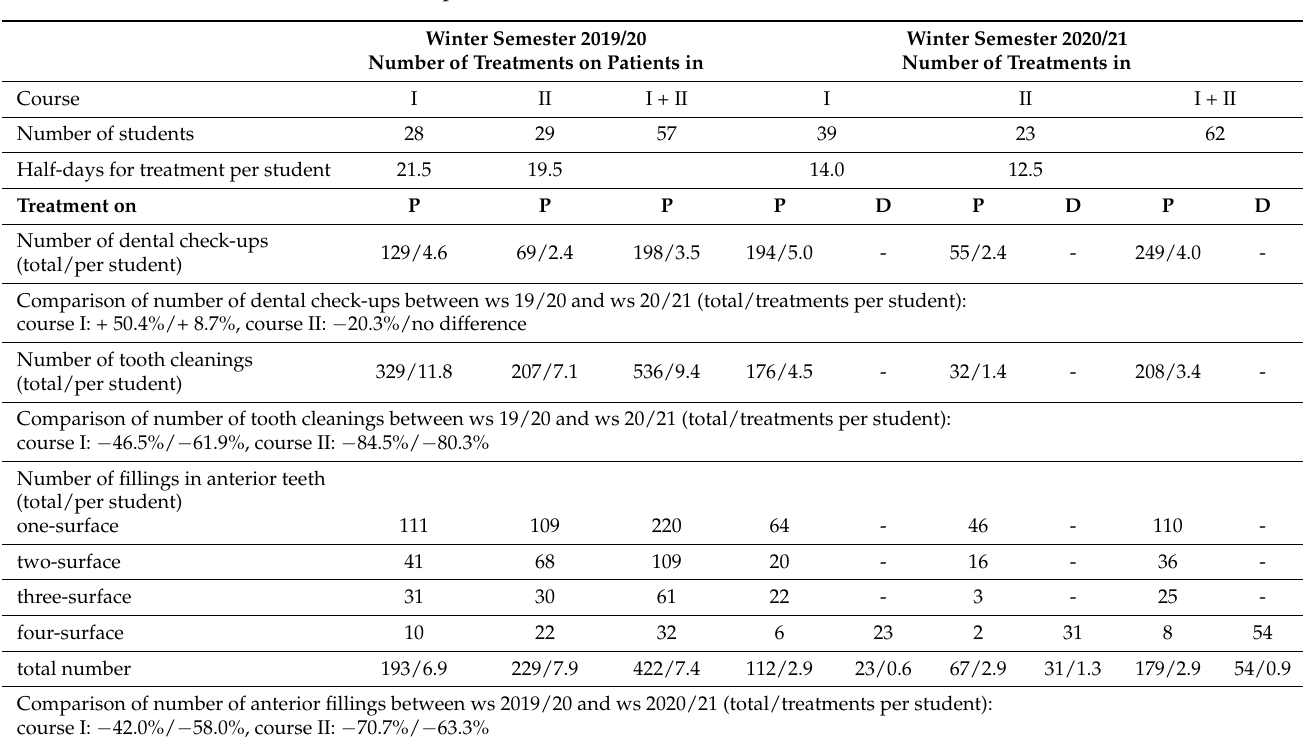
Table 4. Treatments carried out on patients in the winter semester 2019/2020 and 2020/21 in the student courses. Winter Semester 2019/20 Number of Treatments on Patients in